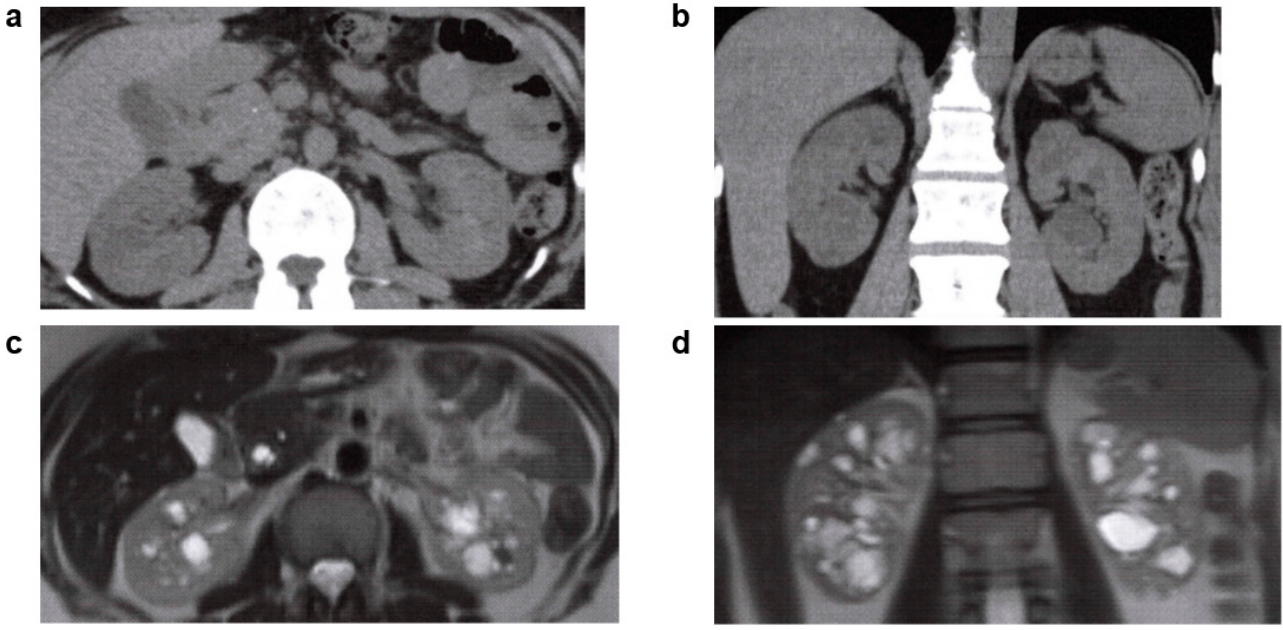
Figure 8. ADTKD: 40s: female, HNF1B gene heterozygous mutation, no family history of polycystic kidney disease or end-stage kidney disease, no history of cerebral aneurysm or heart valve disease, kidney function eGFR 39.2 mL/min/1.73 m 2 (image provided by Toranomon Hospital). ( a ) Non-contrast CT image (horizontal section): multiple cysts in both kidneys, but there is no kidney enlargement. ( b ) Non-contrast CT image (coronal section): multiple cysts in both kidneys, but there is no kidney enlargement. ( c ) MRI T2-weighted image (horizontal section): multiple hyperintense cysts of various sizes are noted near the corticomedullary junction on both kidneys, but there is no kidney enlargement. ( d ) MRI T2-weighted image (coronal section): multiple hyperintense cysts of various sizes are noted near the corticomedullary junction on both kidneys, but there is no kidney enlargement.